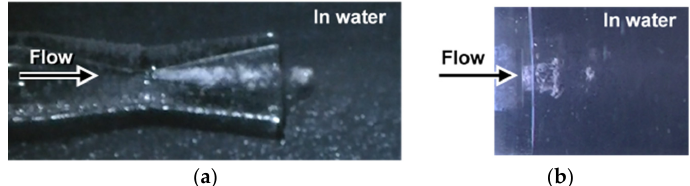
Figure 5. Aspect of cavitation through a nozzle [54]: ( a ) Venturi-type nozzle and ( b ) step-type nozzle. Metals 2019 , 9 , x FOR PEER REVIEW